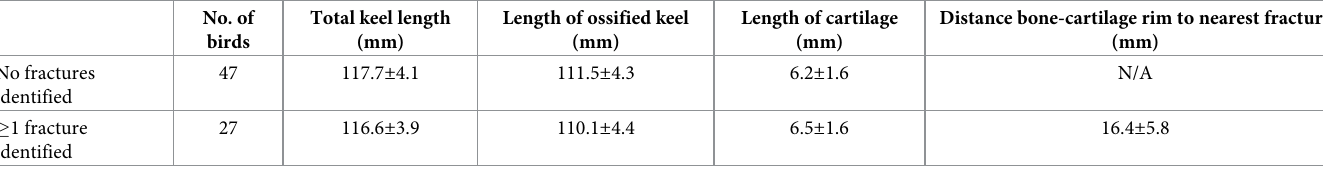
Table 2. Overview of keel length, ossification status and localization of fracture in 32 weeks old birds a . No. of